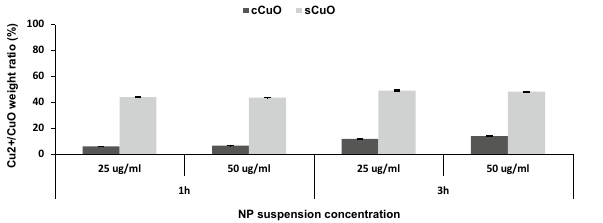
Figure 2. Extracellular copper ions release. The amount of copper ions released by cCuO and sCuO (25 µg/ml, 50 µg/ml) was measured by ICP-OES after 1 h and 3 h of incubation in cell culture medium. Results are shown in the graph as mean [Cu 2+ /CuO] weight ratio percentage ± SD.